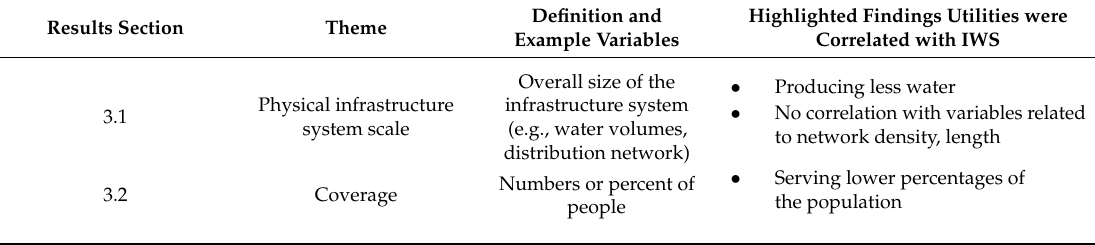
Table 1. Main themes identified through analysis of variables with their definition and highlighted